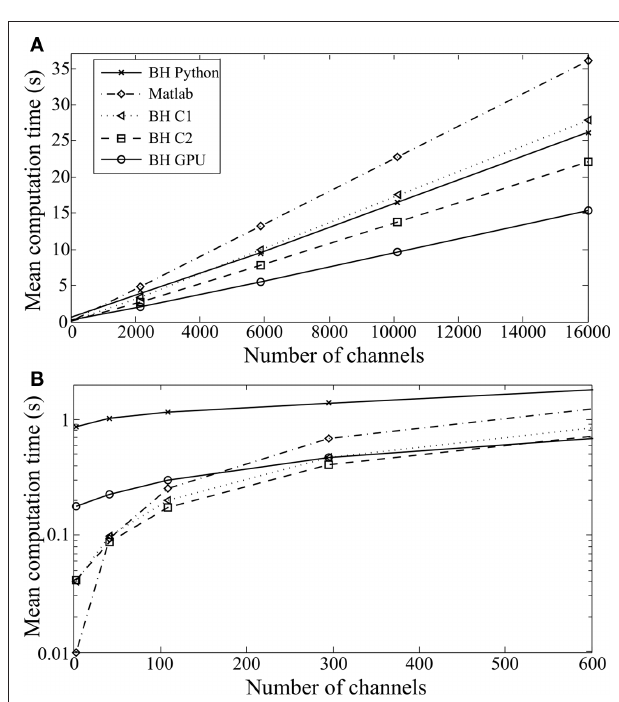
FiGUre 8 | Computation time taken to simulate a DrNL filterbank as a function of the number of channels, with the same algorithms as in Figure 6 [(B) is a magnified version of